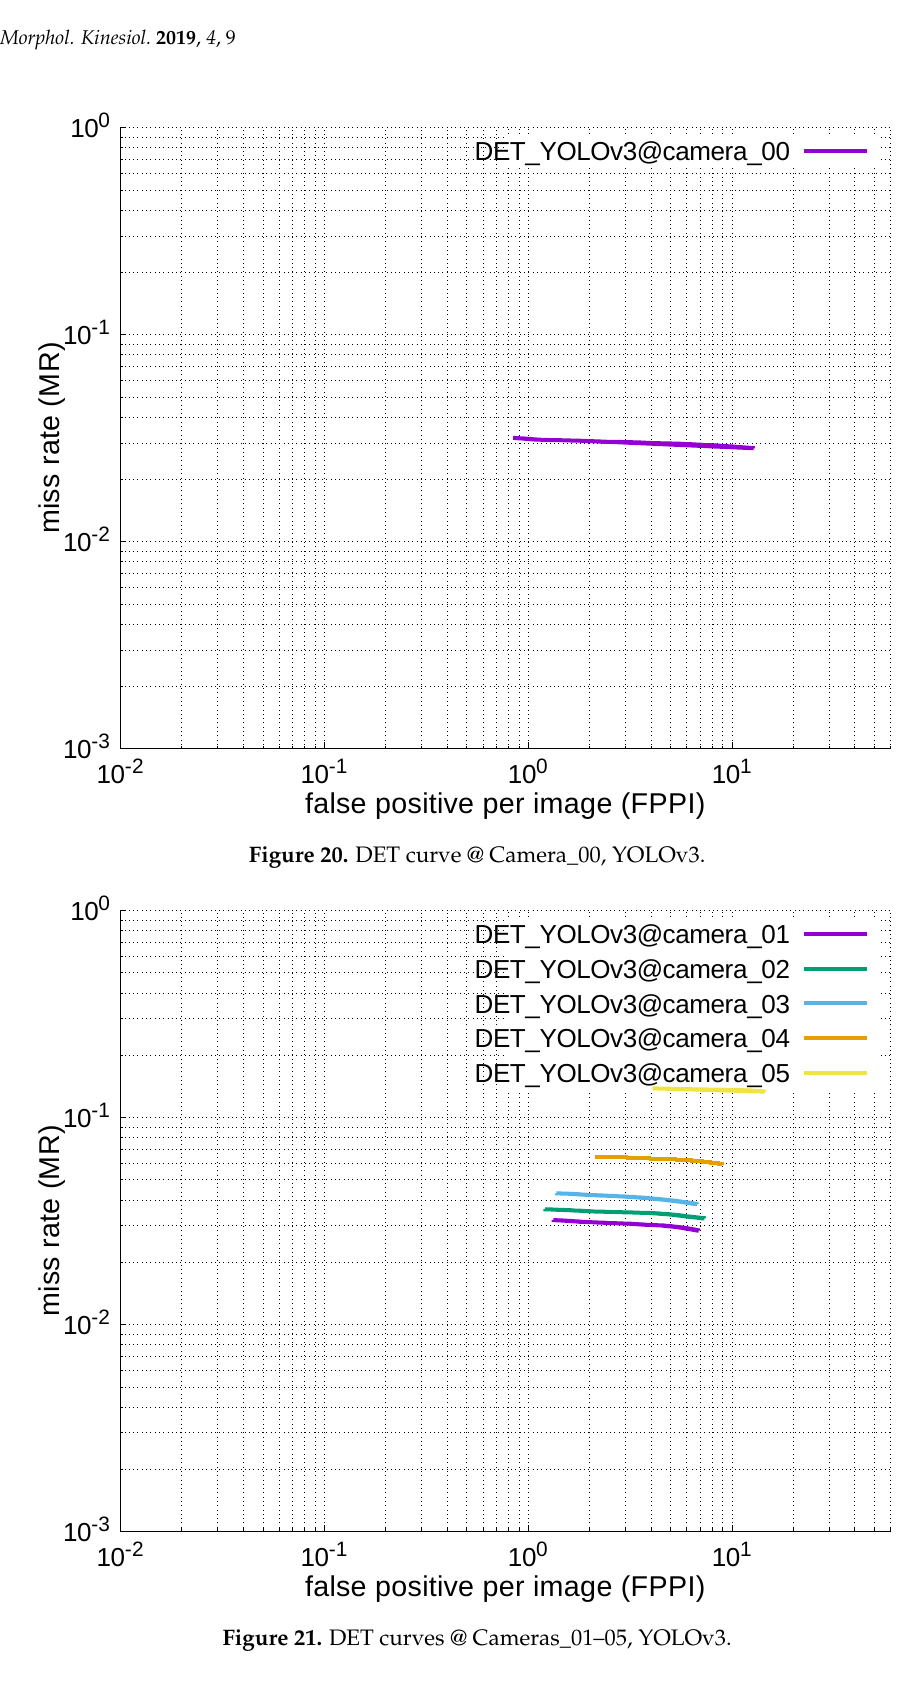
Figure 21. DET curves @ Cameras_01–05,